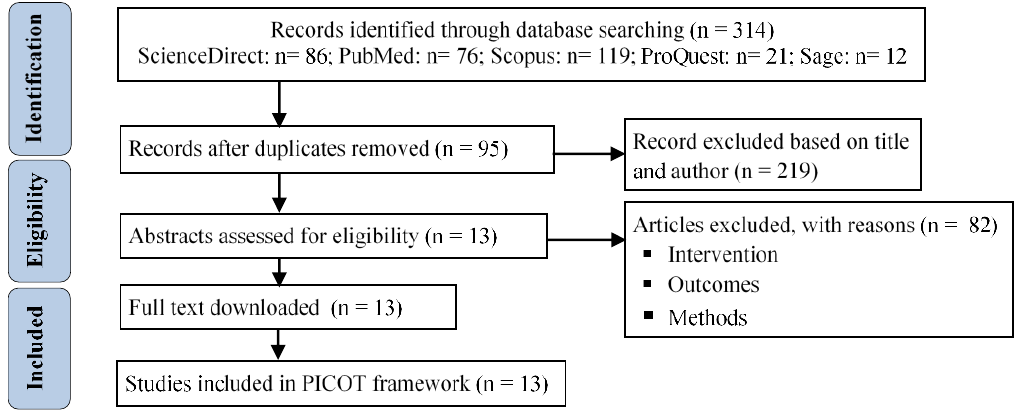
Figure 1 – Flow chart of the study identification process (Liberati, 2009) (A. Liberati et al,